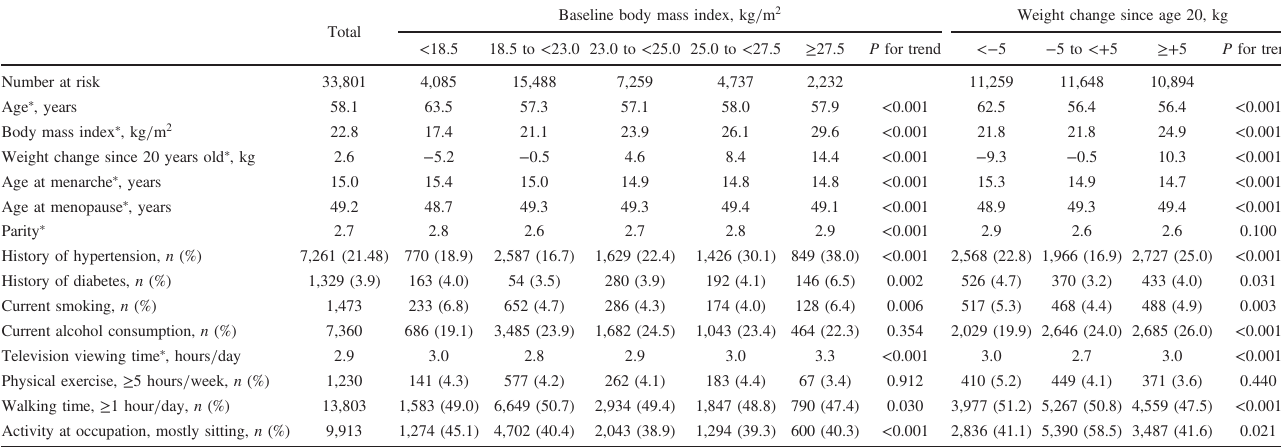
Table 1. Participants ’ baseline characteristics according to baseline body mass index and weight change since age 20